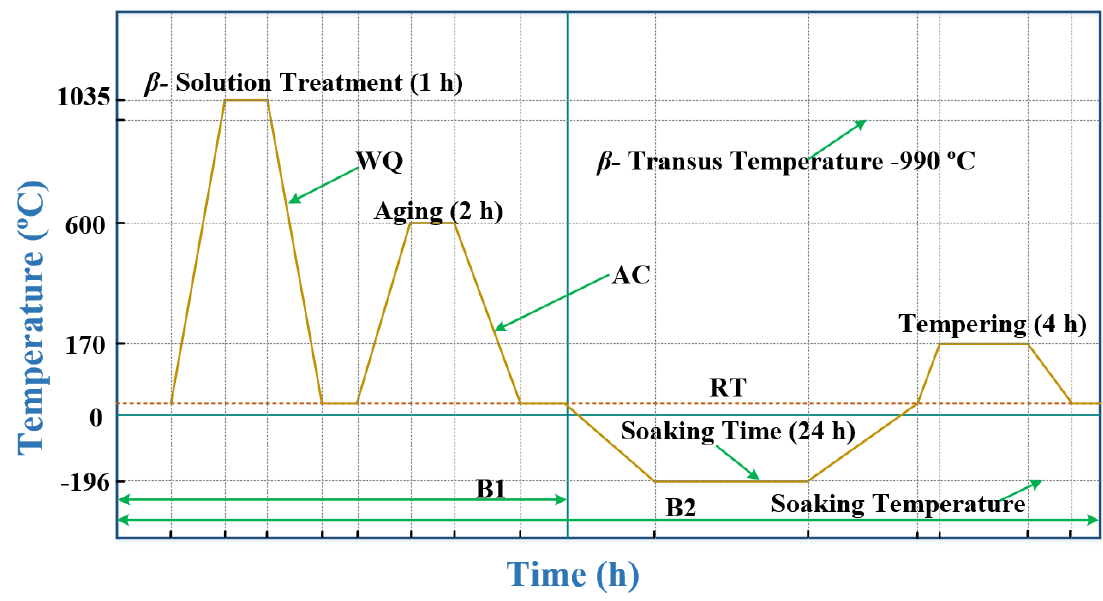
Figure 1. Schematic of thermal treatment schedules.